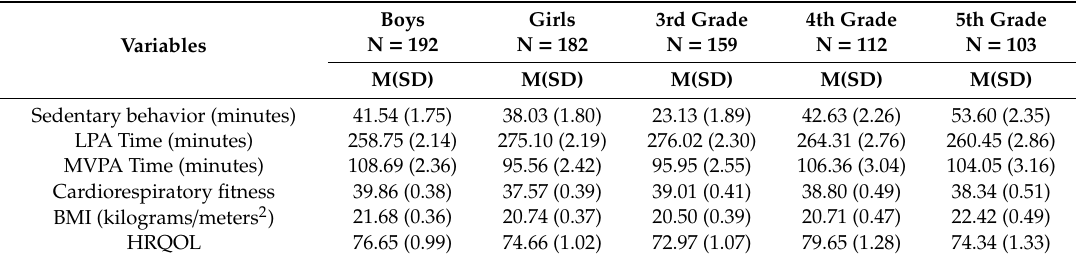
Table 1. Descriptive results of the study variables by sex and grade (N = 374).